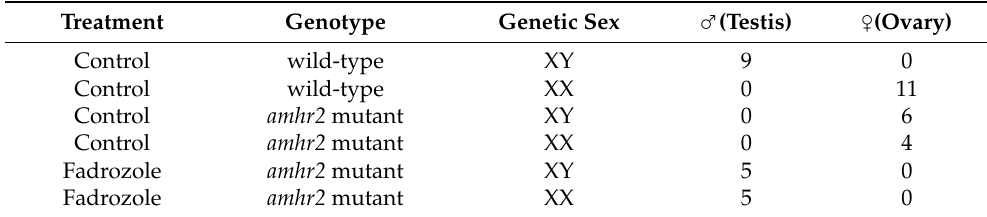
Table 2. Sex ratios in wild-type and amhr2 mutant flounder fed an fadrozole-treated diet or untreated diet